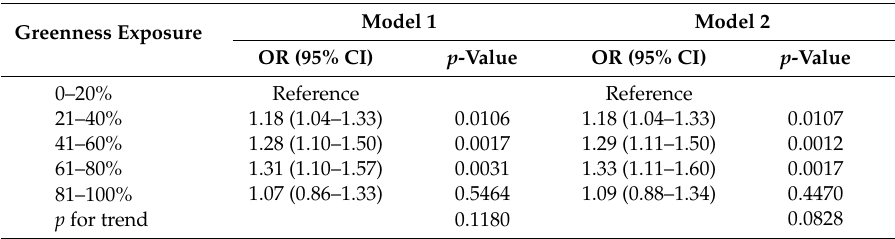
Table 3. Odds ratios (OR) and 95% confidence intervals (CIs) for asthma occurrence according to the level of greenness exposure in preschool children (0–5 years old).